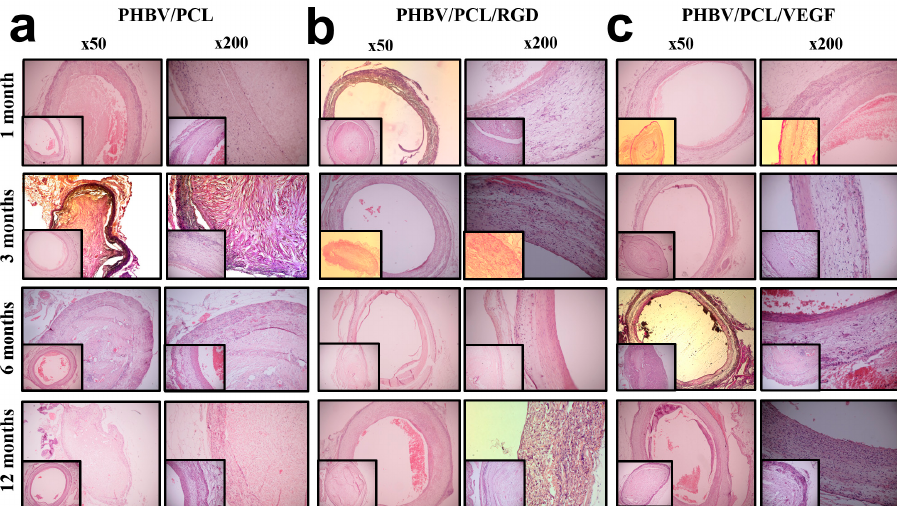
Figure 2. Hematoxylin and eosin (H & E) staining of the unmodified grafts and grafts with either conjugated arginine–glycine–aspartic acid (RGD) peptides or incorporated vascular endothelial growth factor (VEGF) at 1, 3, 6, and 12 months postimplantation; magnification: 50 × and 200 × . Representative images of: ( a ) poly(3-hydroxybutyrate- co -3-hydroxyvalerate)/poly( ε -caprolactone) (PHBV/PCL) grafts; ( b ) PHBV/PCL/RGD grafts; ( c ) PHBV/PCL/VEGF grafts. Images of corresponding patent PHBV/PCL along with occluded PHBV/PCL/RGD and PHBV/PCL/VEGF grafts are presented as bottom